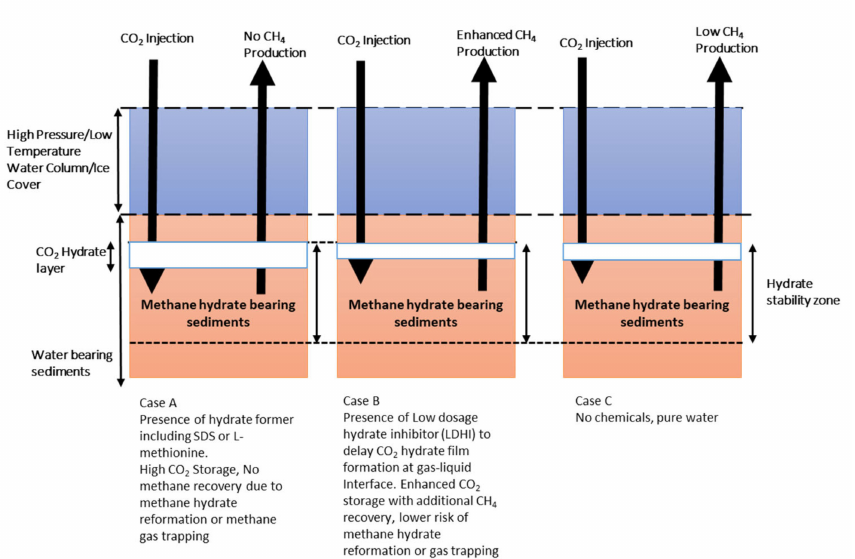
Figure 1. The di ff erence in the formation kinetics of CO 2 hydrate film in the presence of chemicals could control high-density CO 2 storage in hydrate-bearing sediments